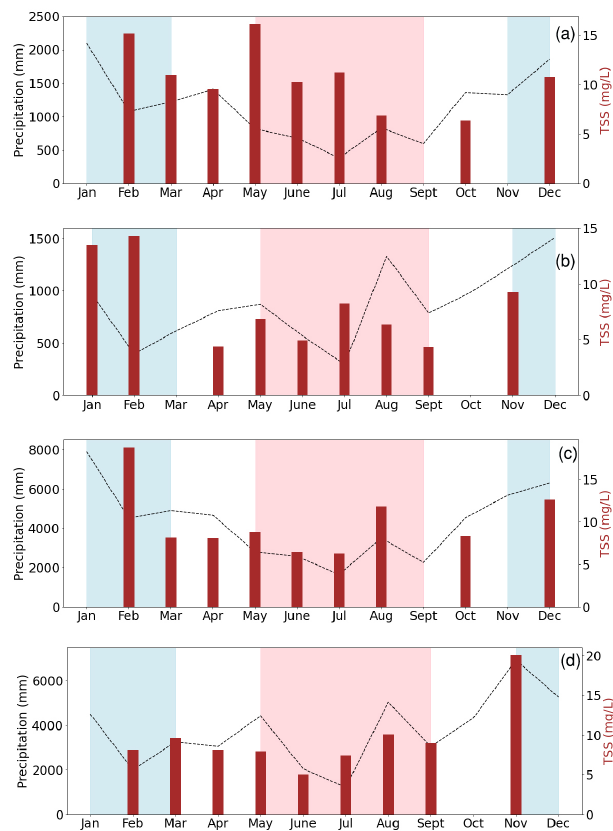
Figure 7. Temporal analysis of precipitation (mm) from the Lupar and Rajang river basins in relation to TSS concentrations (mgL − 1 ) during the NE and SW monsoon periods at the Lupar ( a , 2009; c , 2014) and Rajang ( b , 2009; d , 2014) coastal river point. The NE monsoon months are highlighted using a blue background, the SW monsoon are highlighted using a pink background, and inter- monsoon periods are highlighted using a white